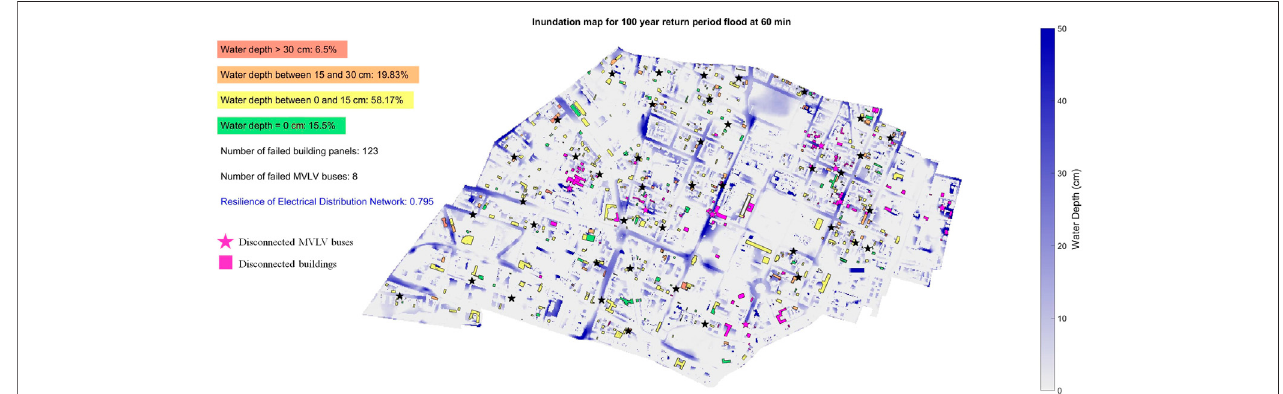
FIGURE 6 | Maxvorstadt Electrical Distribution Flooding at 3,600 s.